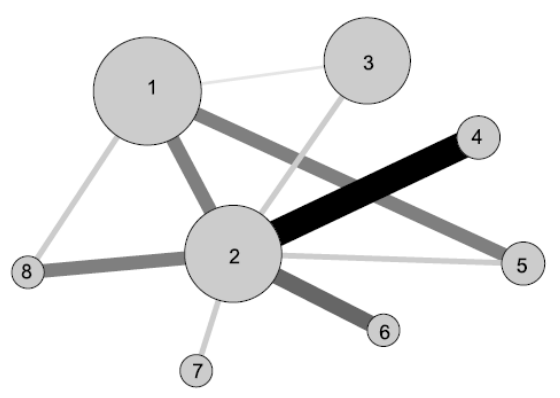
Figure 1. Cluster Structure. Source: Cobo (2012).